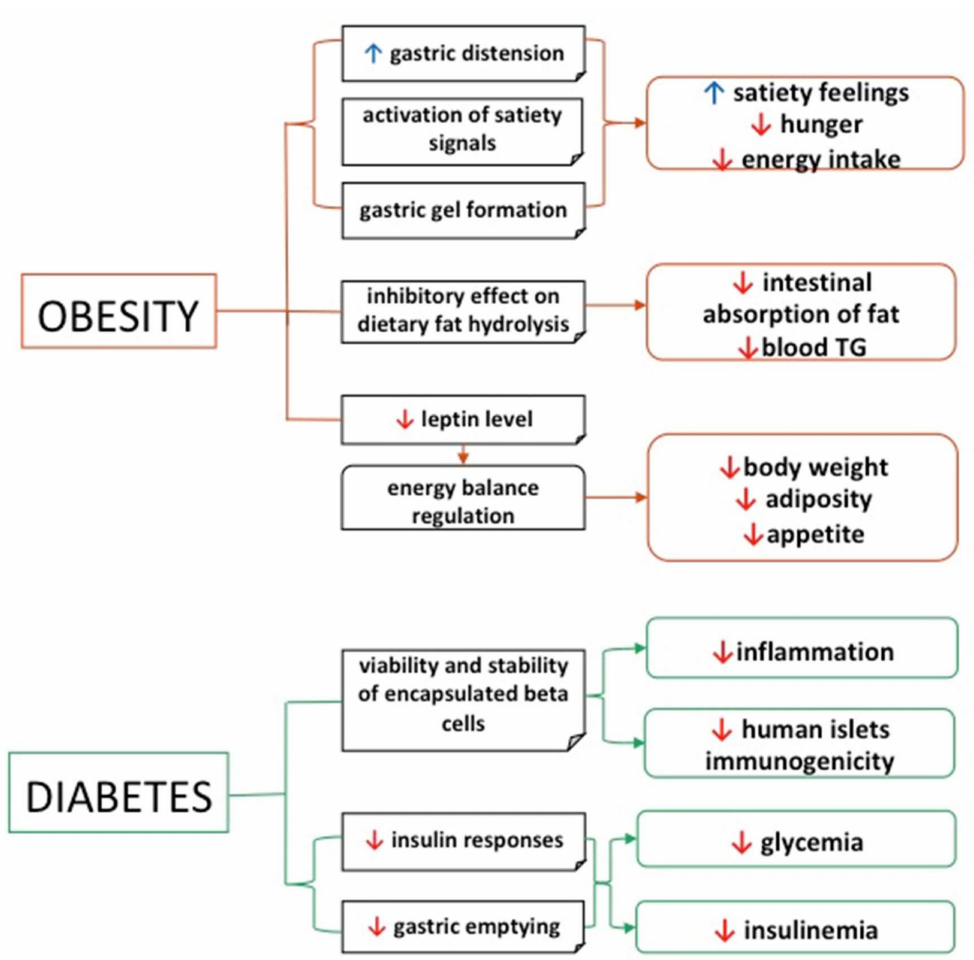
Figure 3. Alginate health benefits, with applications in diabetes and